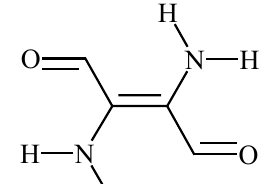
Figure 2. The chromophore of indigo.